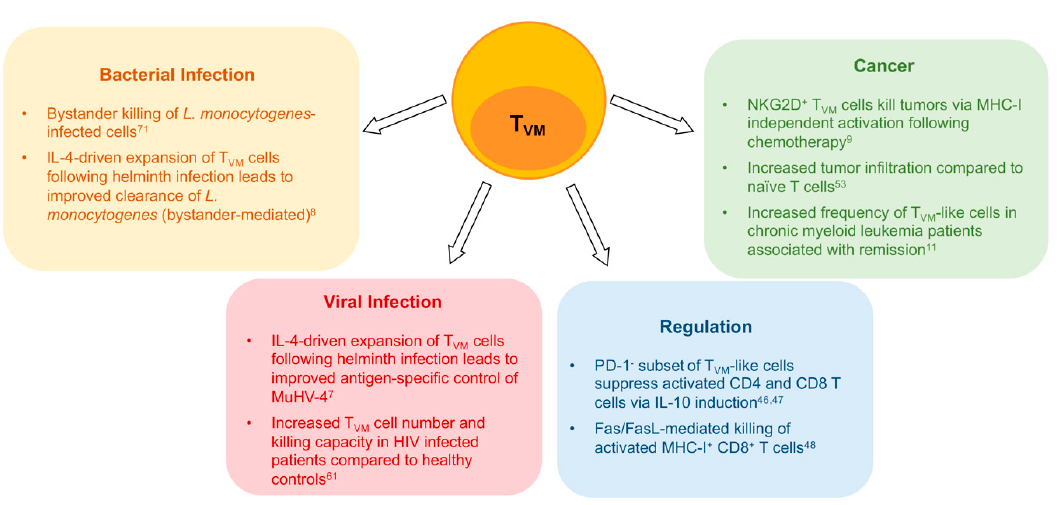
Figure 2. Virtual memory CD8 + T cells (T VM ) participate in various immune responses to pathogens and tumors and may be involved in immune regulation. Boxes indicate the role and possible mechanism of action of T VM cells in different disease or immune contexts.